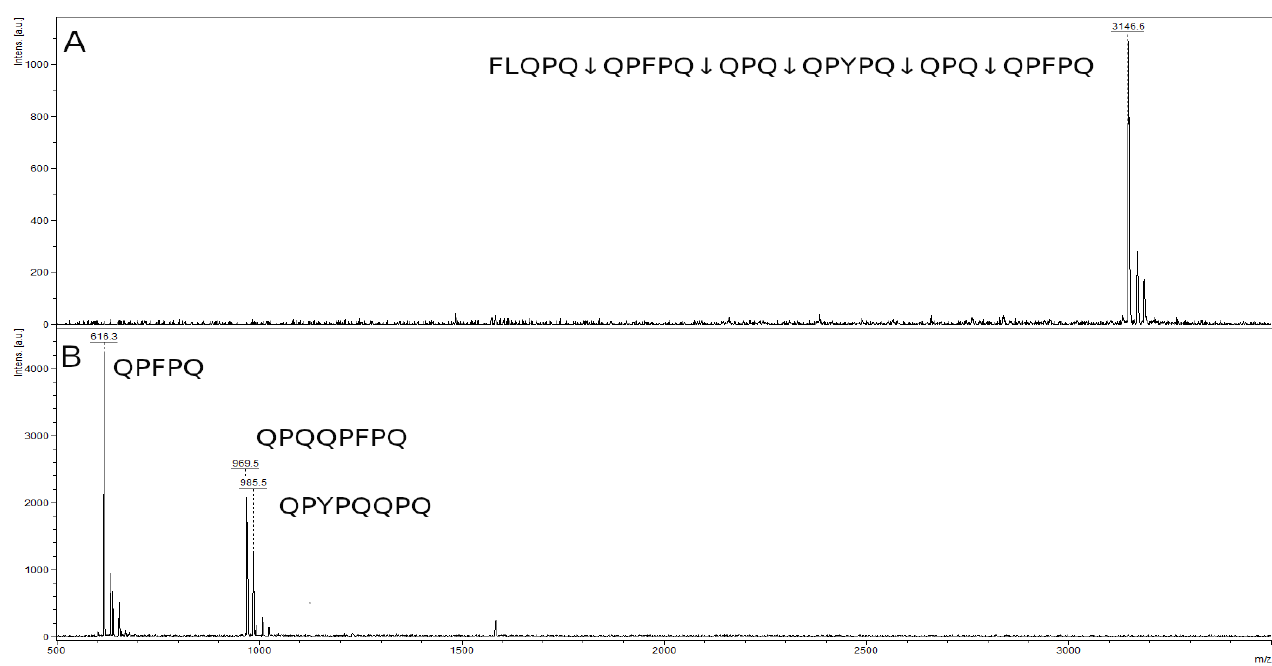
Figure 11. Mass spectra of the original 26-mer FLQPQQPFPQQPQQPYPQQPQQPFPQ peptide ( A